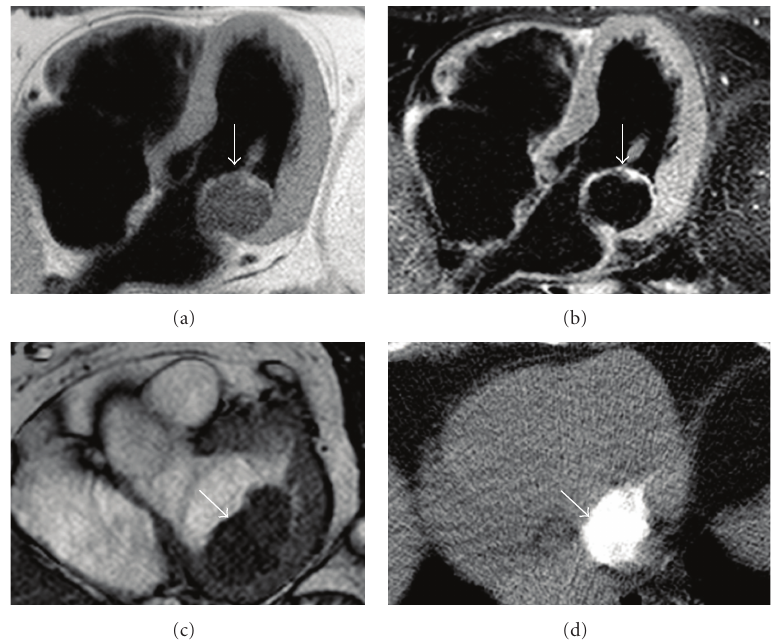
Figure 6: Mitral annular calcification (MAC). A classic “pseudotumour” MAC is seen in older patients, often with a history of diabetes or hypertension. It presents as focal mass-like lesions most frequently adjacent to the lateral mitral annulus ((a) and (b), white arrow). In this example the signal characteristics on CMR are typically being low signal on T1-weighted images (a) and T2-weighted images (b). Its relation to the posterior mitral annulus is well appreciated on the short axis bright-blood cine view ((c), white arrow). Noncontrast MDCT excludes any residual diagnosis about the diagnosis—the mass is of very high attenuation consistent with calcium ((d), white